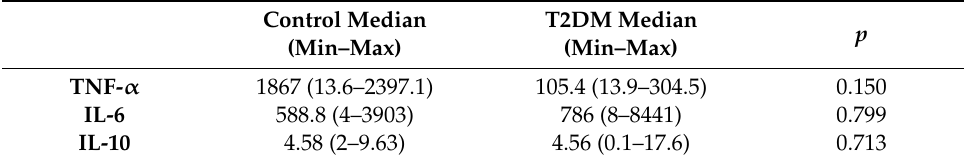
Table 2. Cytokine Production Without Butyrate Treatment.